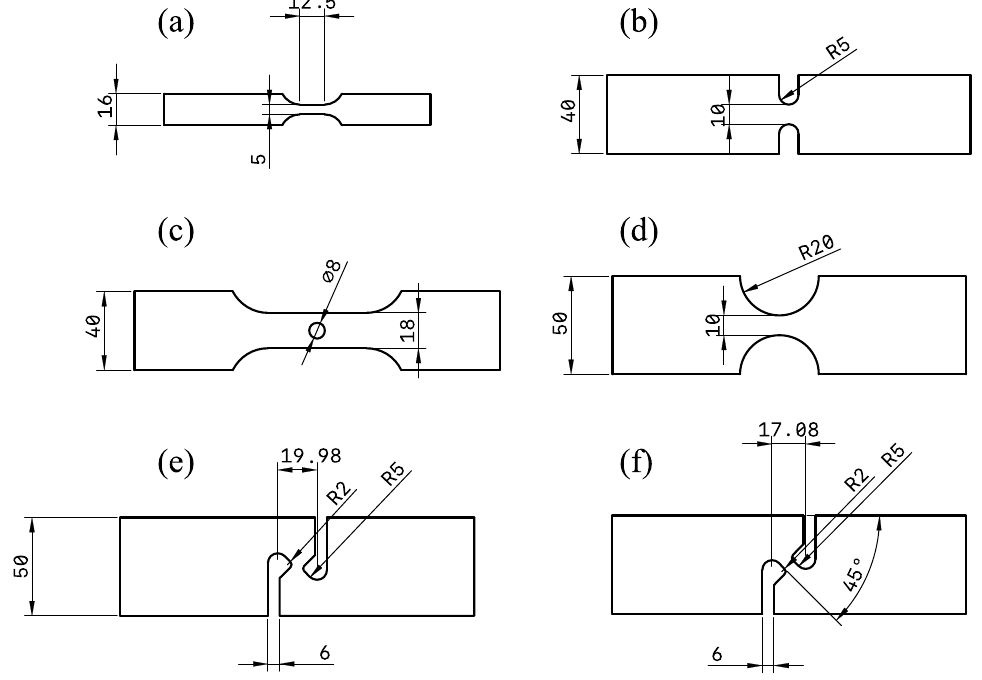
Figure 1. Specimen configuration for the tests (unit: mm): ( a ) Tensile, ( b ) R5 notched, ( c ) Center hole, ( d ) R20 notched, ( e ) Shear, and ( f )